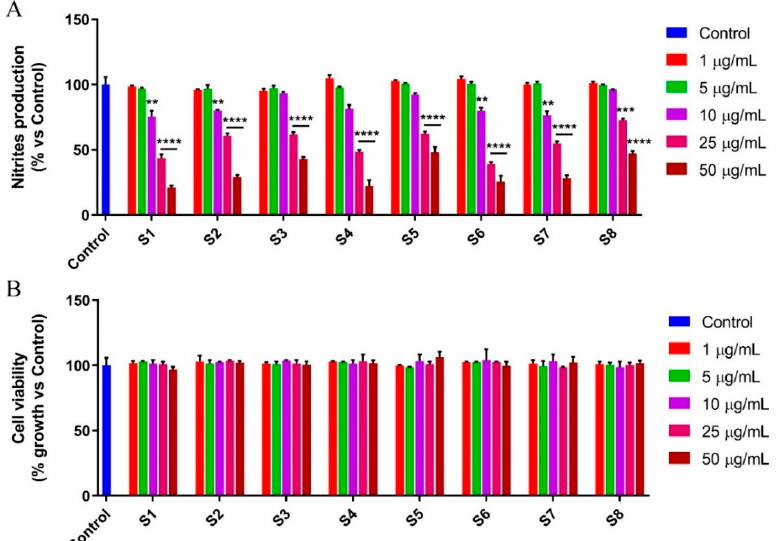
Figure 4. S1–S8 extracts significantly reduce nitric oxide (NO) production. Nitrites production ( A ) and cell viability ( B ) were assessed by the Griess and MTT assays, respectively, after 24 h of treatment of the LPS-stimulated RAW 264.7 cell line with sage extracts, at increasing concentrations (from 1 to 50 µg/mL). The results of the Griess assay are expressed as a percentage of nitrites production vs. control, while the MTT assay results are indicated as a percentage of cell viability vs. control. Values are the mean ± SD of three independent experiments, each one performed in triplicate. P -values were calculated vs. control; ** p < 0.01; *** p < 0.001; **** p < 0.0001.